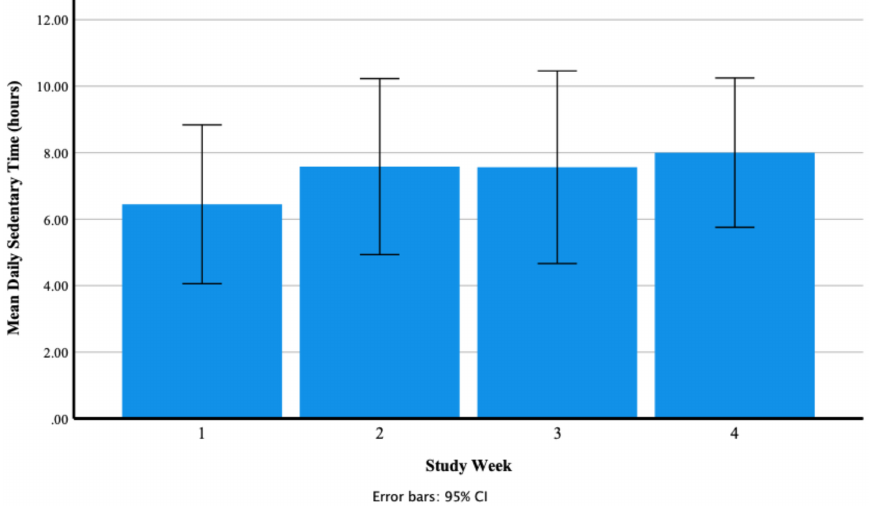
Figure 4. Participants’ mean daily sedentary time (hours) as recorded via the Fitbit Charge 4 activity tracker.